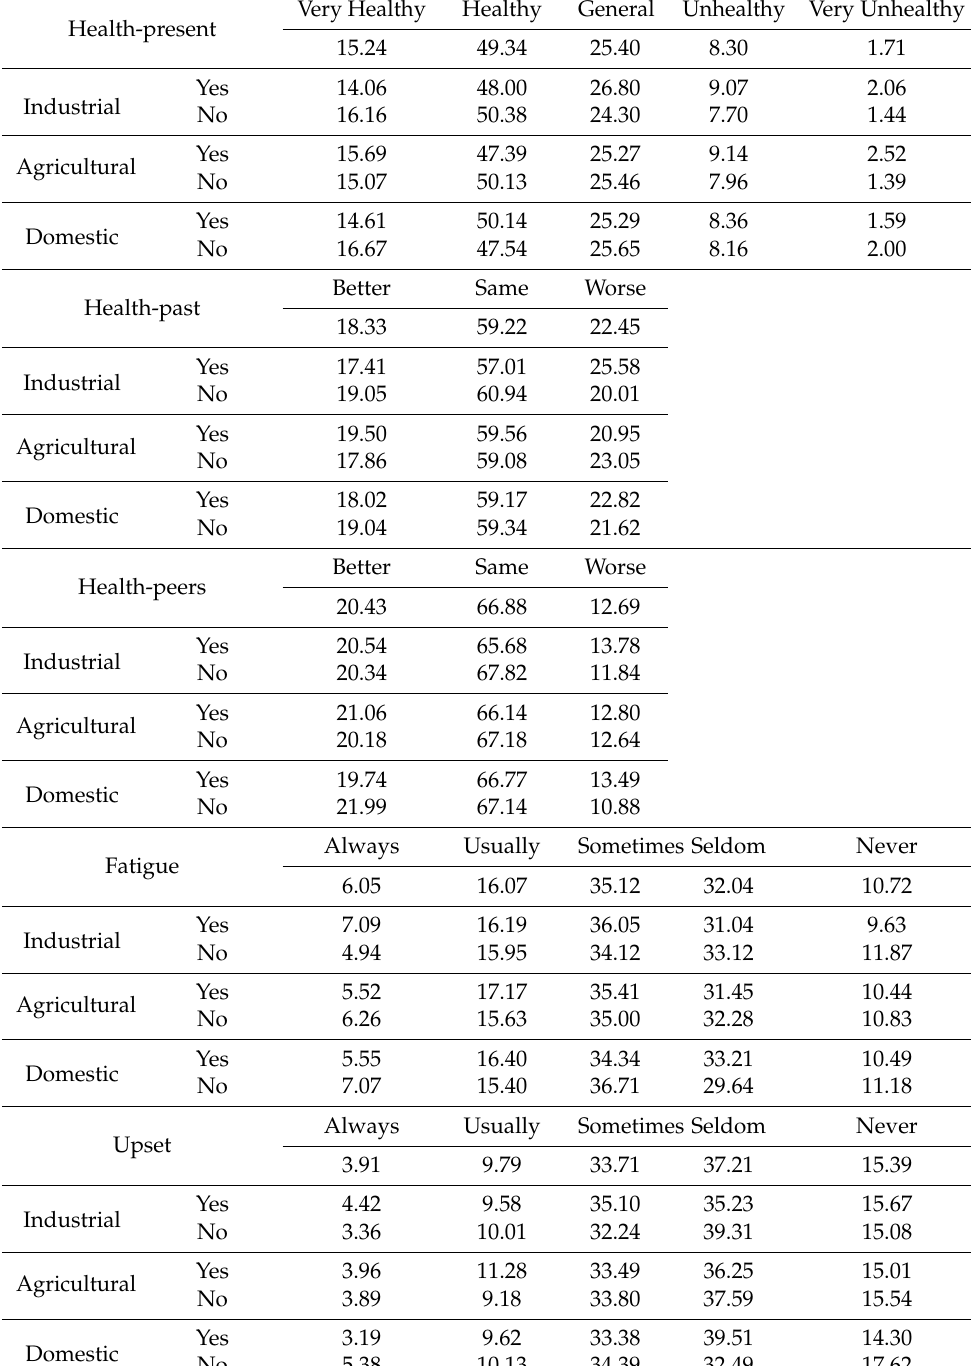
Table 2. The response distribution between health-related variables and wastewater